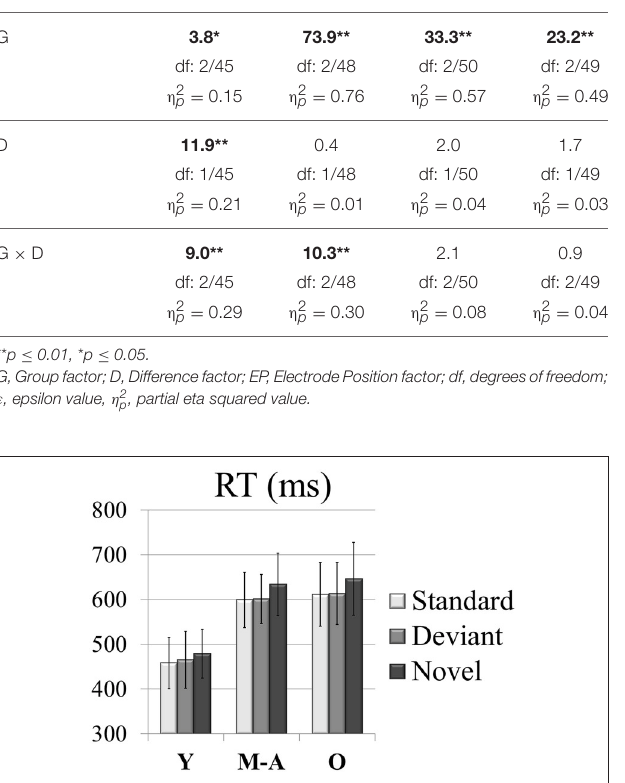
FIGURE 2 | Mean values of RTs (inms) in each condition (Novel, Deviant, and Standard) in all three age groups (Y, young; M-A, middle-aged; O,